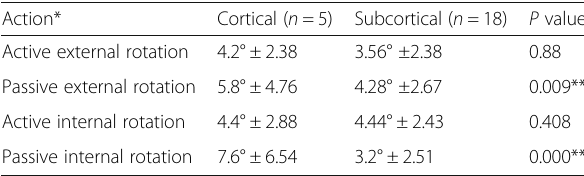
Table 5 Comparison between patients with cortical